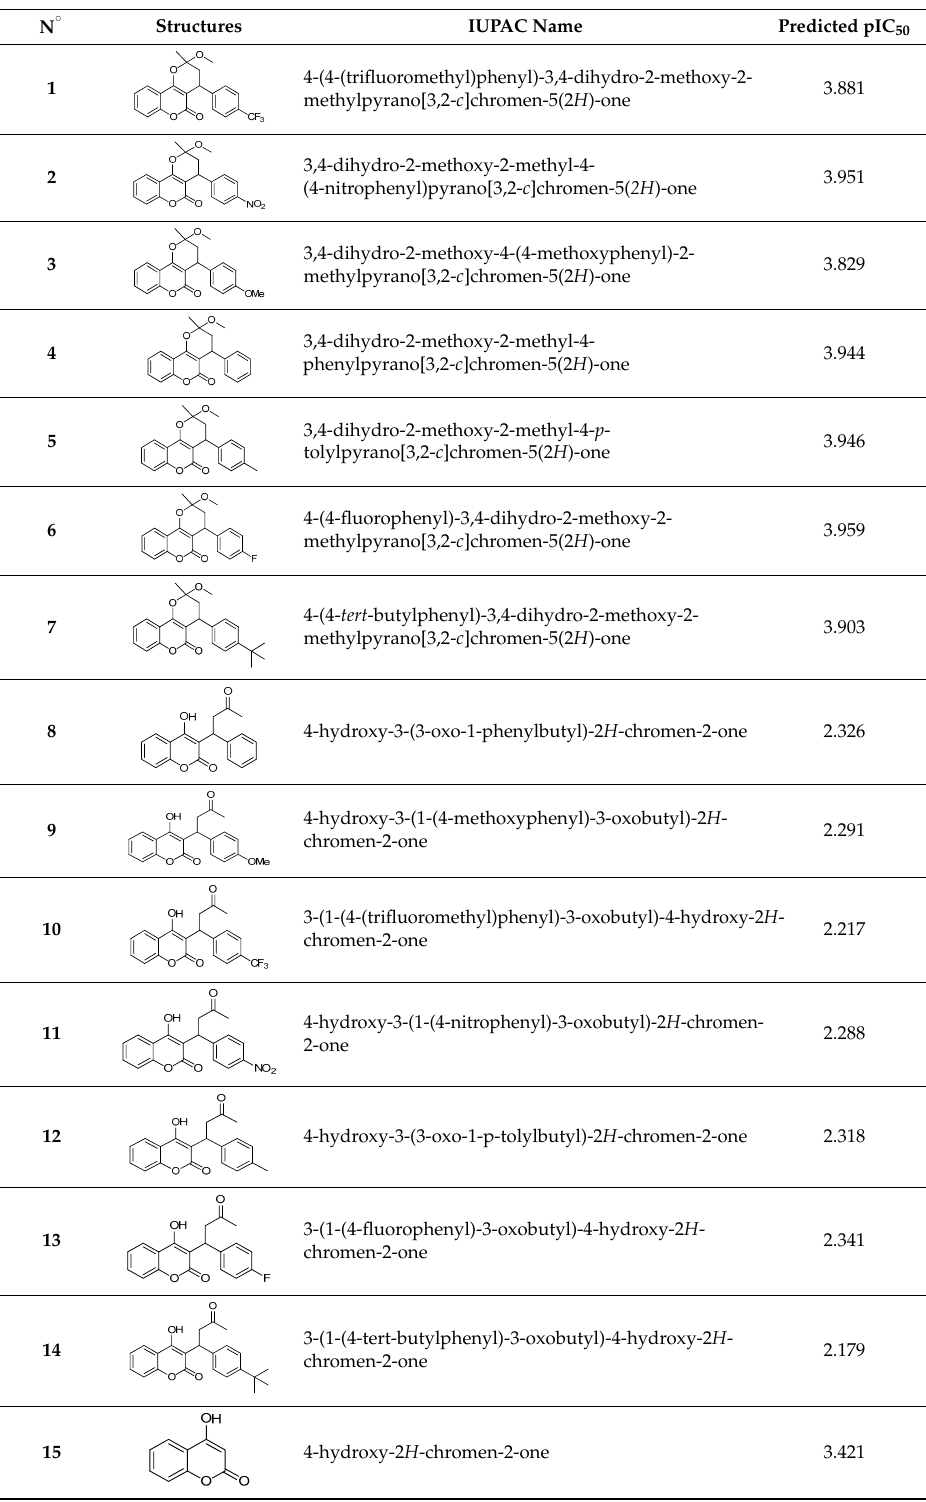
Table 1. Predictions of the pIC 50 values.